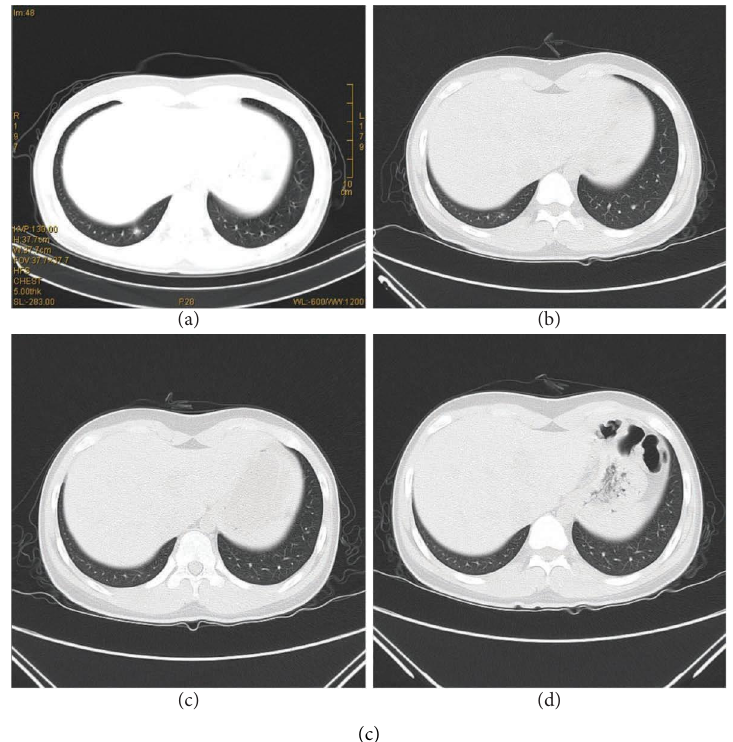
Figure 3: (a) Computed tomography imaging of an asymptomatic carrier who developed symptoms at a later stage. A 57-year-old woman who had hypertension for fve years had close contact with a confrmed COVID-19 patient (her husband). (A) Te frst computed to- mography imaging scan showed an area of consolidation in the right middle lobe. (B and C) Seven days later, the woman developed a slight cough; computed tomography imaging showed that the area of consolidation was enlarged in the right middle lobe. (D–F) At 11 days, new lesions developed in both the upper and lower lobes. (G–I) In the early improvement stage at 13 days, lesions in the bilateral lung area shrank and decreased in density. (J–L) Te lesion in the left lung had disappeared, while the right lung lesions had been markedly absorbed. (b) Computed tomography imaging of a symptomatic COVID-19 patient. A 46-year-old man who lived in Wuhan had an intermittent cough and tested positive for viral nucleic acid. (A and B) On the day of admission, multiple patches of ground-glass opacity were observed in both upper lobes and the left lower lobe. (C and D) Four days later, computed tomography imaging showed that the lesion in both upper lobes was enlarged, and the ground-glass opacity had transformed into ground-glass opacity mixed with consolidation. An air bronchogram was observed in the right upper lobe, and new lesions appeared in both upper lobes. (E and F) In the early improvement stage, the lesions in both upper lobes shrank and refected decreased density. (G and H) In the late improvement stage, the lesions in both upper lobes had been markedly absorbed with only patchy ground-glass opacity remaining. (c) Computed tomography imaging of a special case without symptoms (an asymptomatic carrier). A 16-year-old boy was isolated because his parents were confrmed symptomatic COVID-19 patients. (A) Te frst computed tomography imaging scan revealed a small high-density lesion (arrow) in the right lower lung lobe. (B) Four days later, the lesion in the right lower lobe had undergone marked shrinking (arrow). (C) At the six-day follow-up, the lesion had further shrunk and became a lesion of only 0.5cm in diameter (arrow). (D) At the 11-day follow-up, the lesion had completely